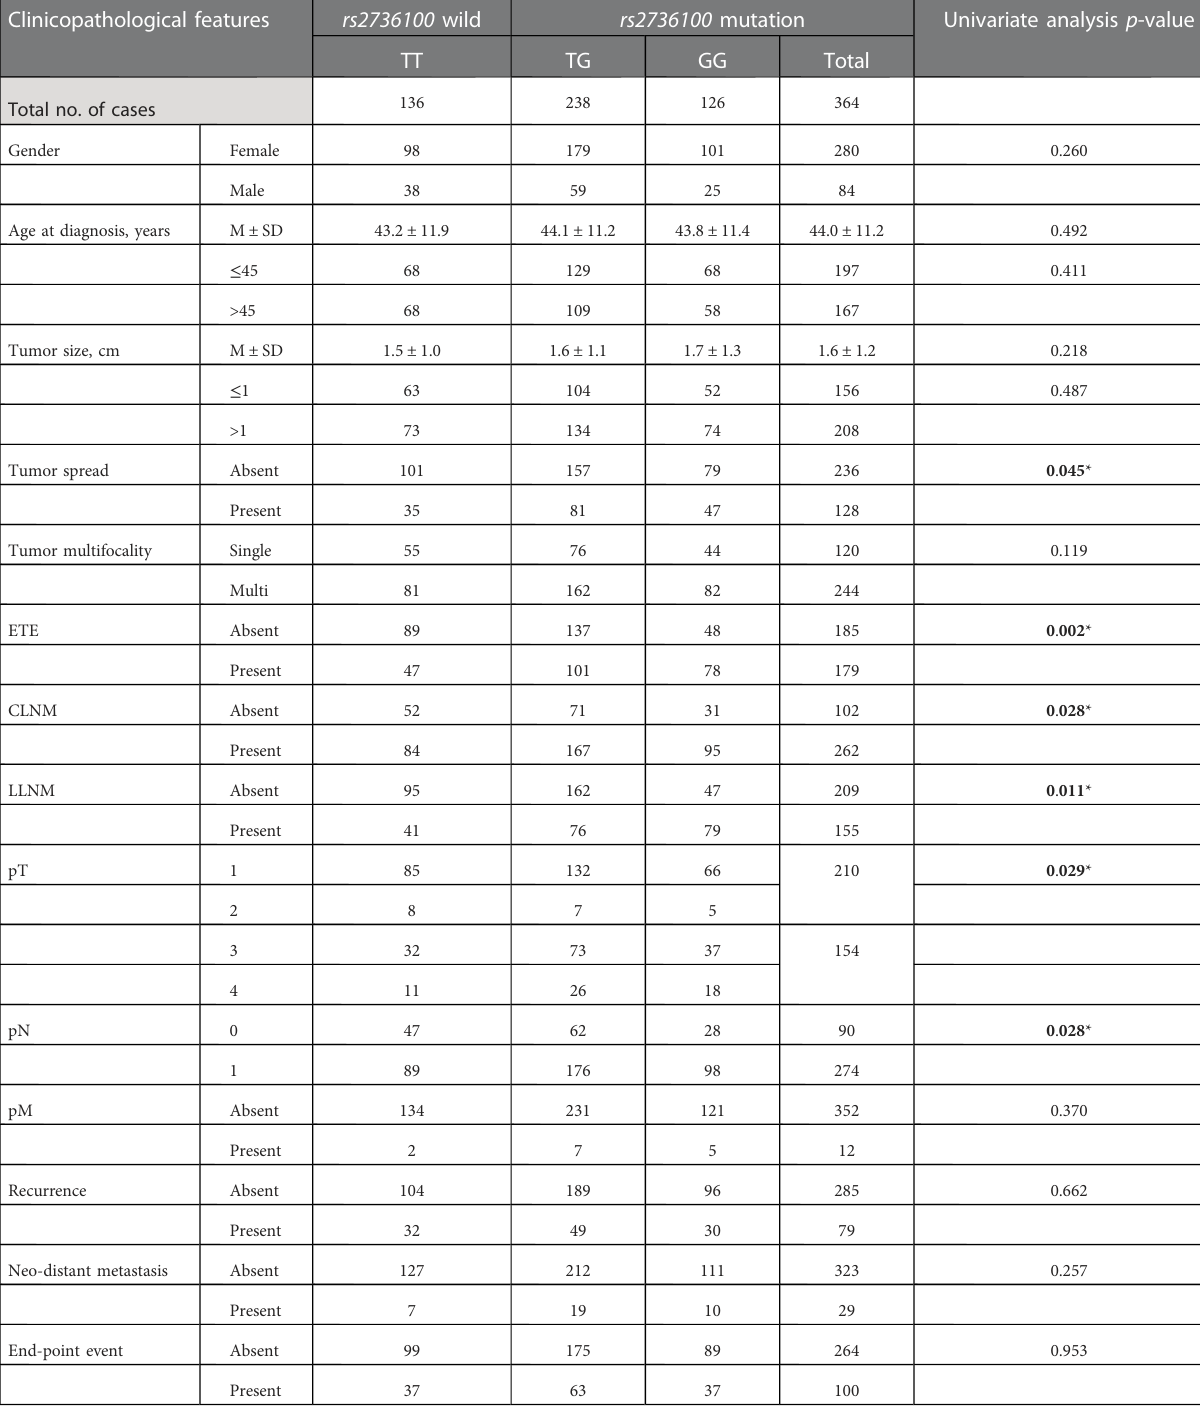
TABLE 1 Demographic clinicopathological features of 500